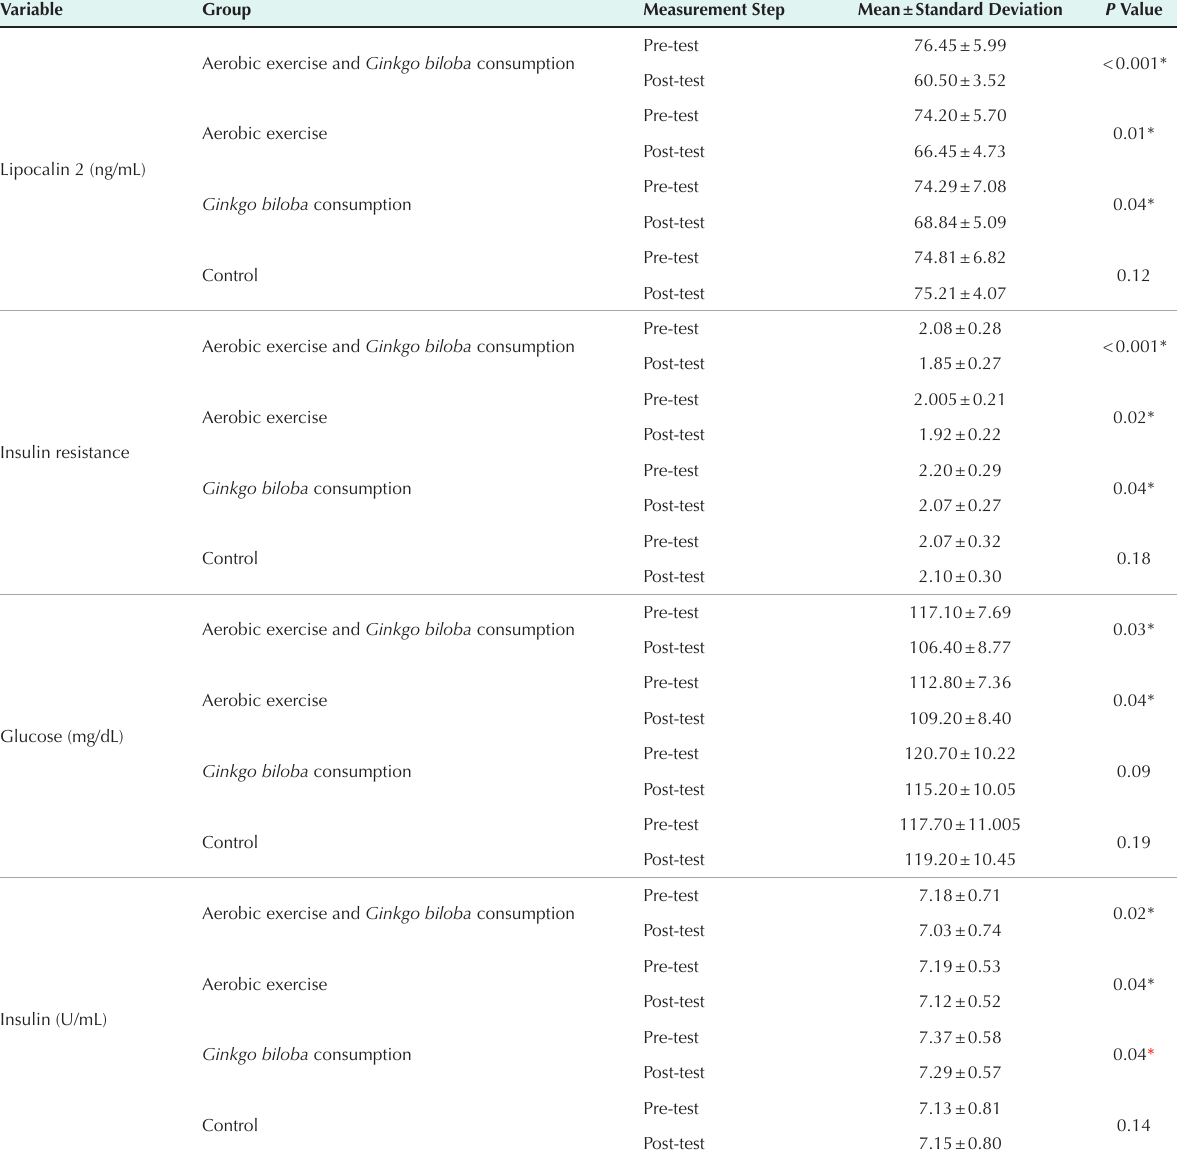
Table 2. Statistical Indicators Related to Research Variables